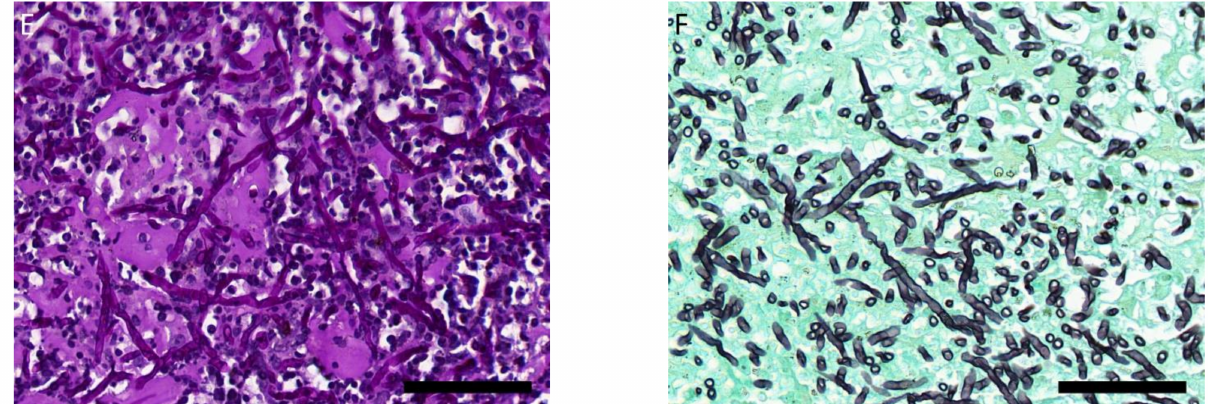
Figure 3. Histopathology. ( A ) Granuloma ( ☆ ) composed of a central area of eosinophilic cellular debris admixed with mixed inflammatory cells in the dermis; hematoxylin and eosin (HE) stain; and scale bar = 500 μ m. ( B ) Central lumen and faveolar spaces ( ☆ ) of the right lung lobe filled with large amounts of erythrocytes, necrotic cell debris, and mixed inflam- matory cells; HE stain; and scale bar = 500 μ m. ( C ) Thromboembolism with fungal elements ( ☆ ) in the lung; HE stain; And scale bar = 50 μ m. ( D ) Thromboembolism with fungal elements ( ☆ ) in the liver; HE stain; and scale bar = 100 μ m. ( E ) Branched, septate fungal hyphae with rare arthroconidia; periodic acid-Schiff (PAS) stain; and scale bar = 50 μ m. ( F ) Branched, septate fungal hyphae with rare arthroconidia; Jones' methenamine silver (JMS) stain; and scale bar = 50 μ m.